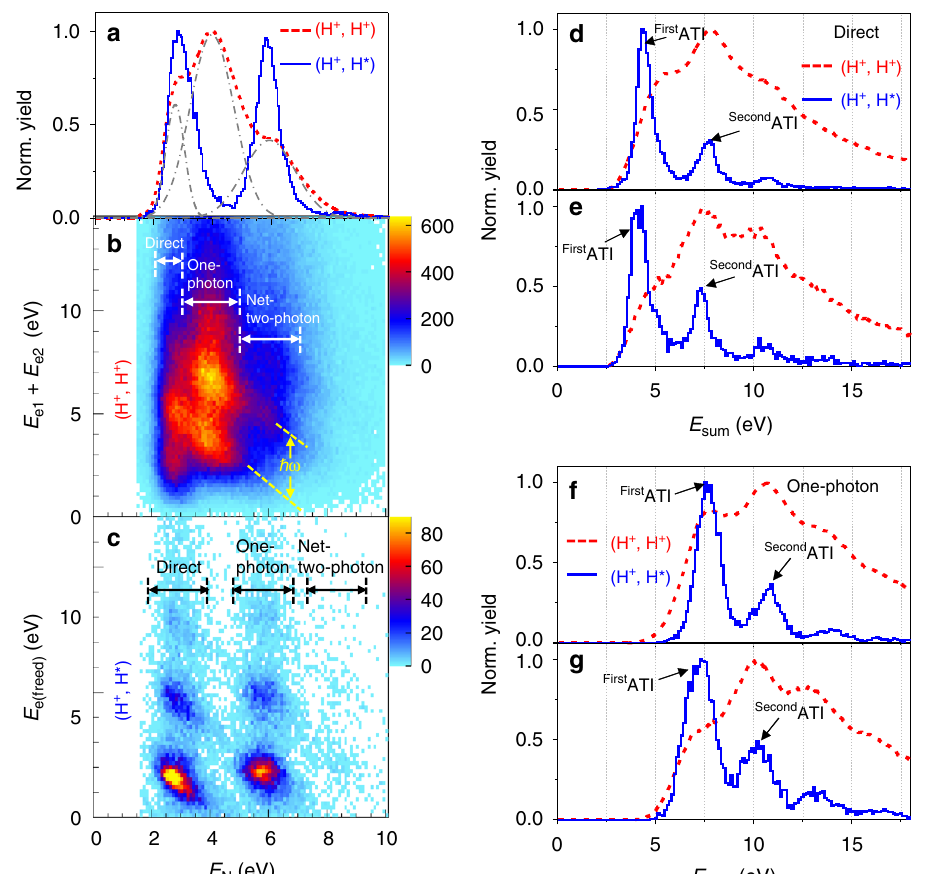
Fig. 2 Electron-nuclear joint energy spectra. a Measured E N spectra of the nuclear fragments of the (H + , H + ) (red dashed line) and (H + , H * ) (blue solid line) channels, driven by a linearly polarized UV laser pulse at an intensity of 0.75 × 10 14 W/cm 2 . b , c The joint energy spectra (JES) of the freed electrons and nuclear fragments of the ( b ) (H + , H + ) and ( c ) (H + , H * ) channels. Three photon-resolved pathways, that is, direct, one-photon, and net-two-photon pathways, in the strong- fi eld breaking of H 2 molecules, are indicated by the white arrows in b and black arrows in c , respectively. The yellow dashed lines in b are used to guide the photon-energy-spaced tilted strips in the JES. d – g The E sum spectra of the freed electrons and nuclear fragments of the ( d ), ( e ) direct and ( f ), ( g ) one-photon pathway of the (H + , H + ) and (H + , H * ) channels driven by the linear UV laser pulses with intensities of ( d ), ( f ) 0.75 × 10 14 W/cm 2 and ( e ), ( g ) 1.0 × 10 14 W/cm